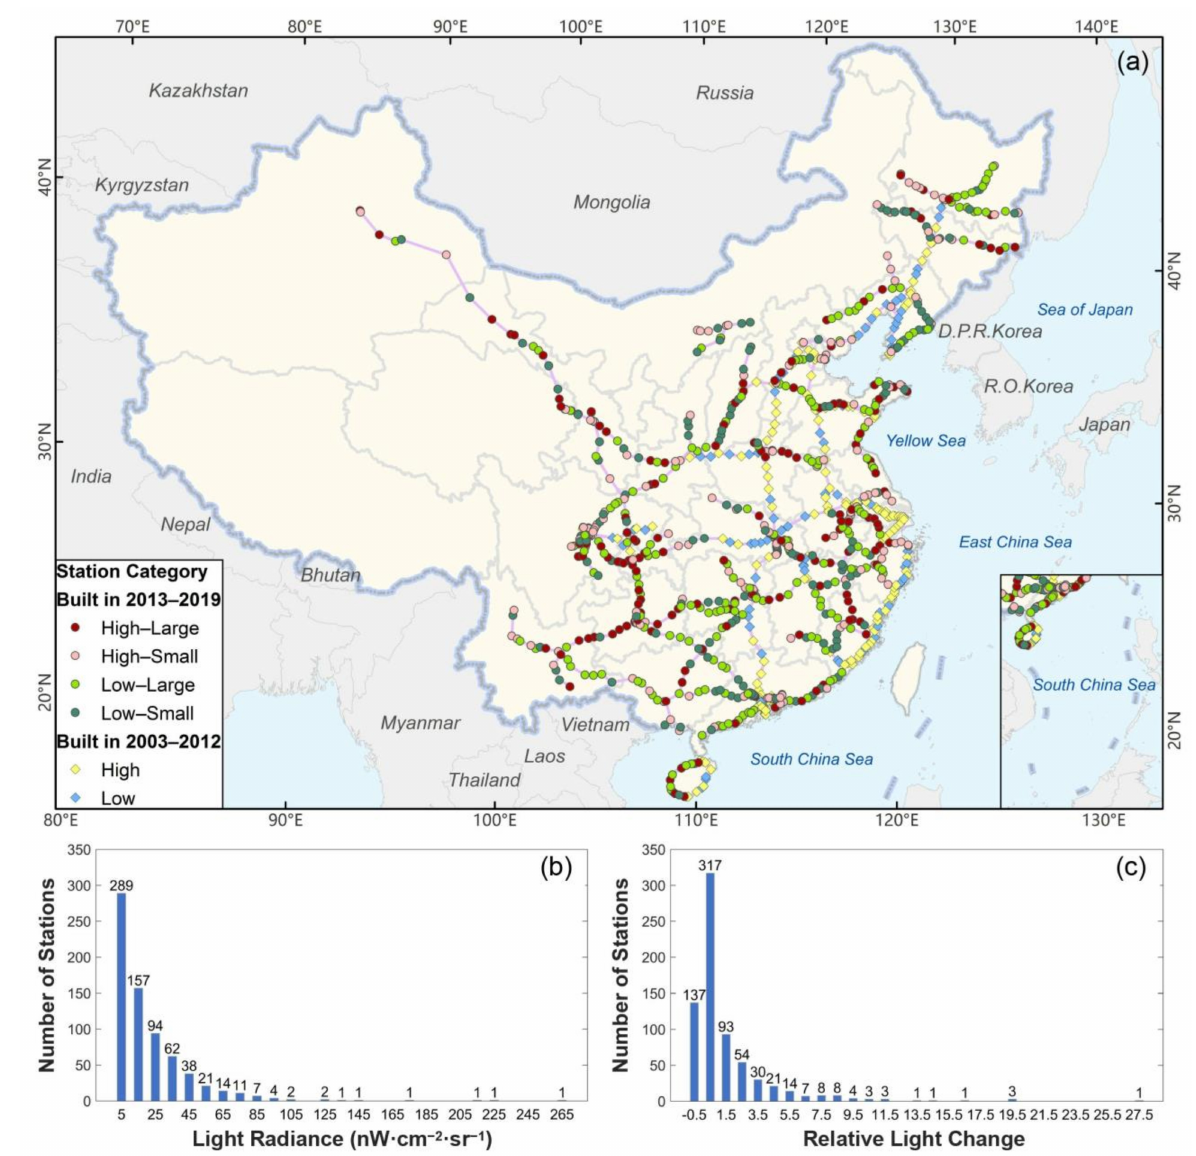
Figure 5. Classification basis and results of HSR stations. ( a ) Spatial distribution of HSR stations after classification. ( b ) Frequency distribution histogram of average brightness during operation for stations started HSR operation from 2013 to 2019 and ( c ) frequency distribution histogram of relative brightness changes for stations started HSR operation from 2013 to